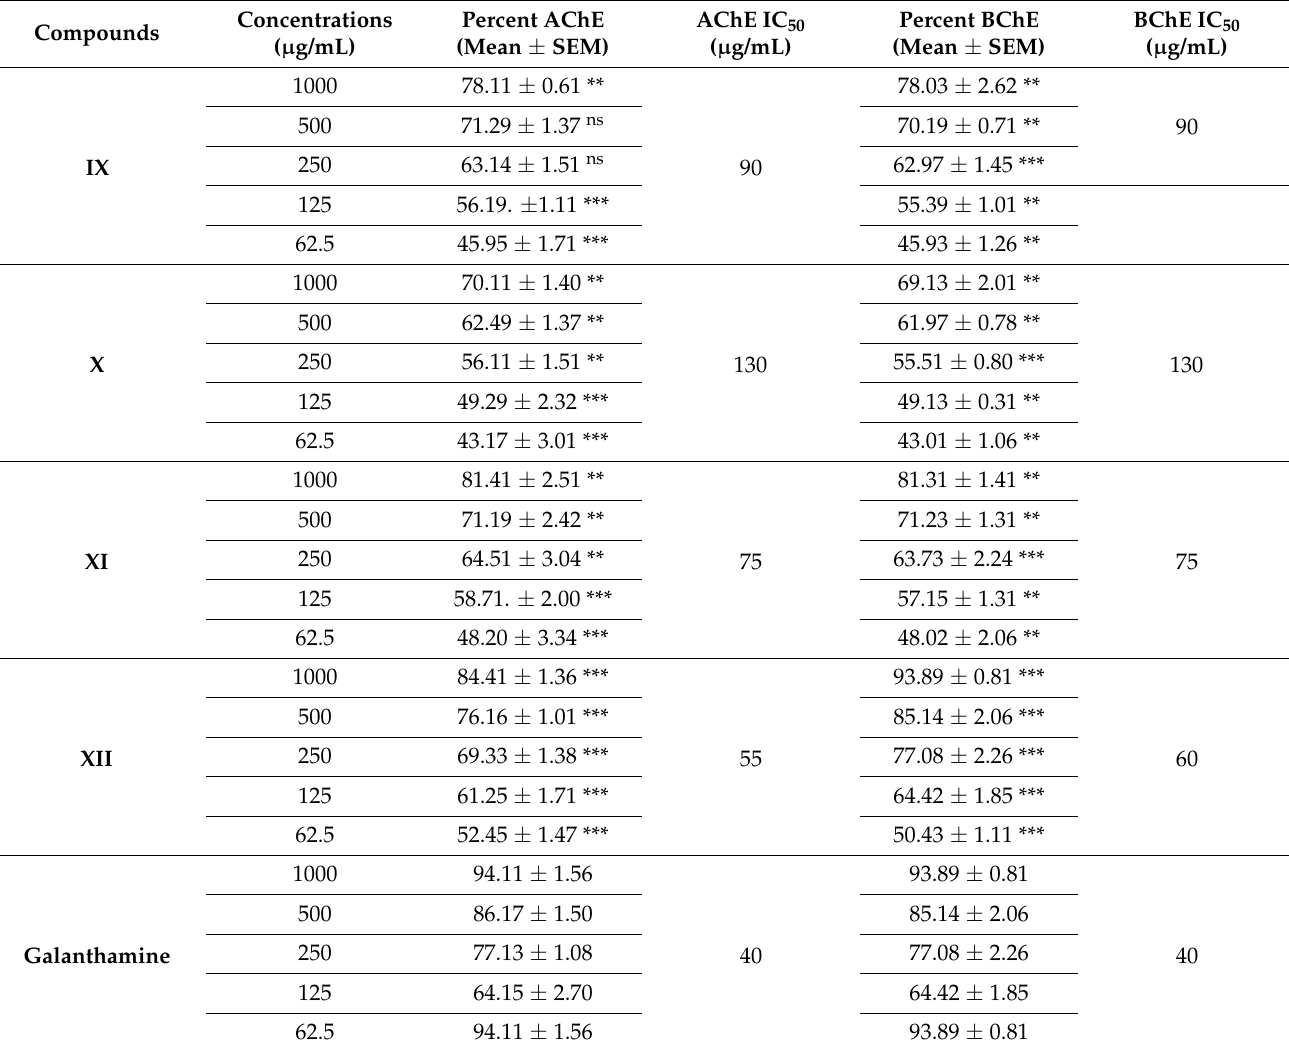
Table 2. Acetylcholinesterase (AChE) and butyrylcholinesterase (BChE) %inhibition exhibited by isolated compounds.